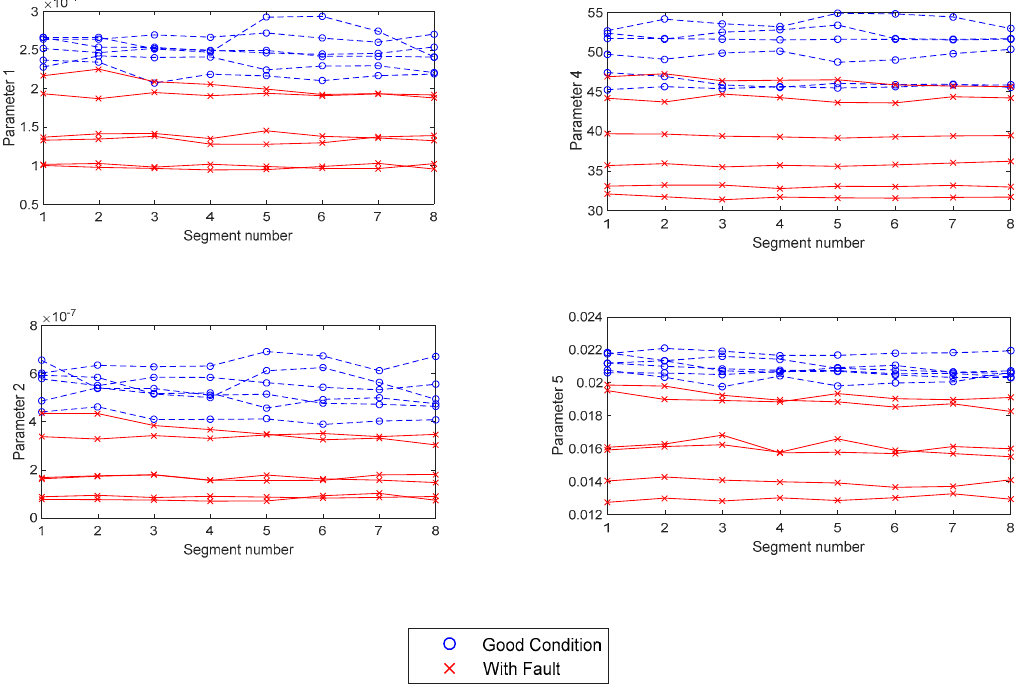
Figure 11. Statistical parameters 1, 2, 4, and 5 in the frequency domain to gear sets in good condition and with fault.